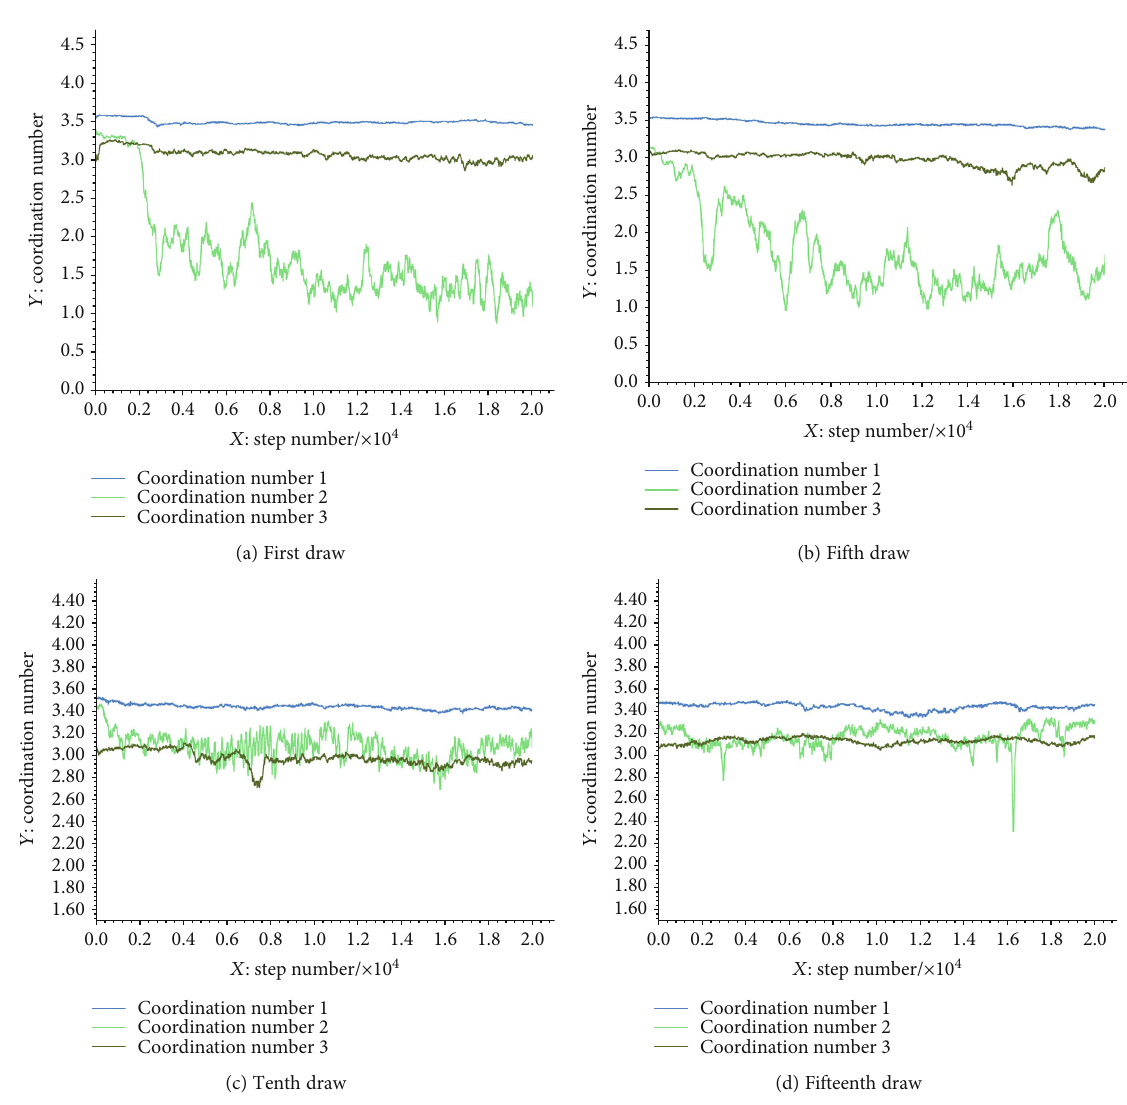
Figure 9: Change law of the coordination